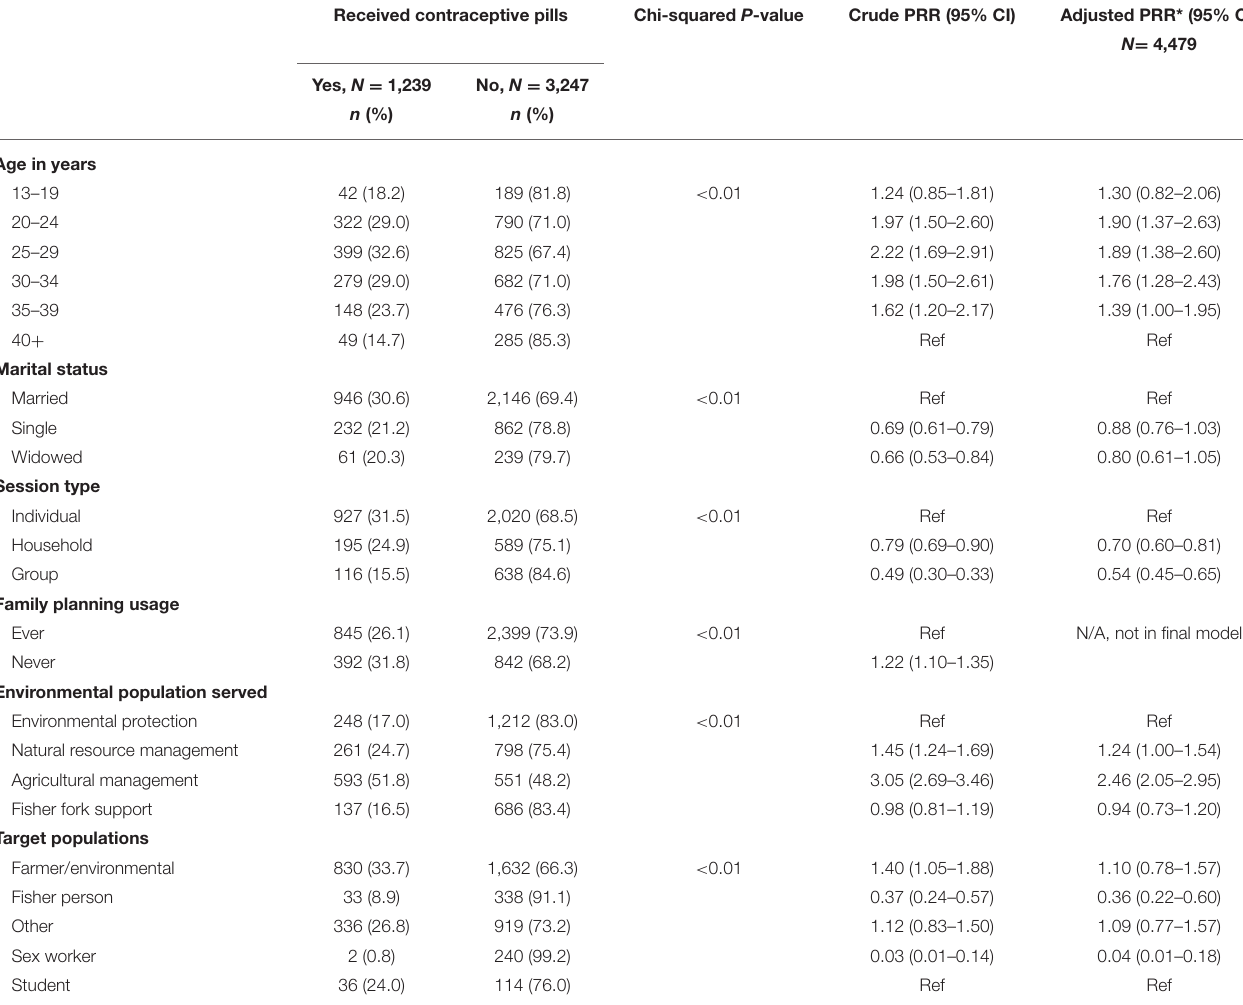
TABLE 3 | Results of multivariable log-binomial regression: factors associated with receiving contraceptive pills among